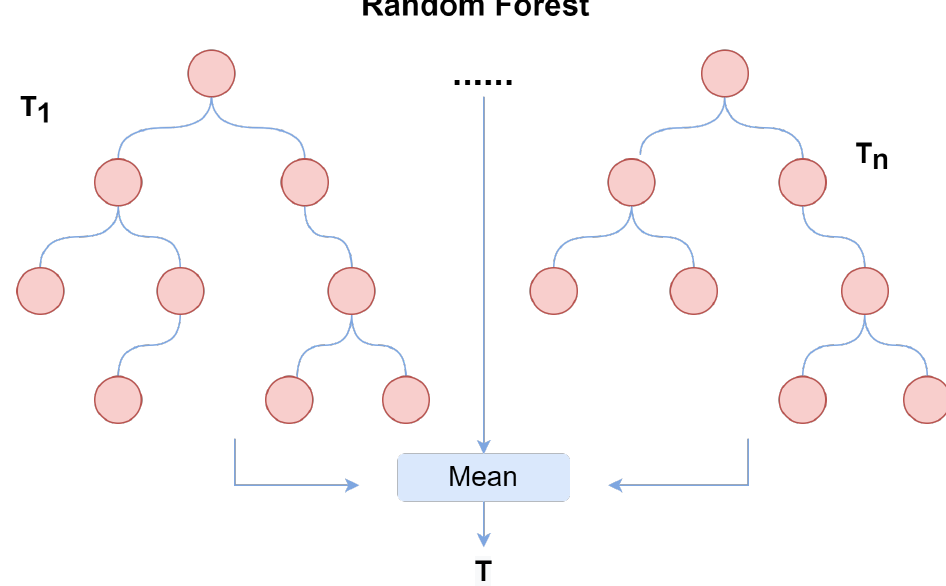
Figure 5. Working structure of a random forest